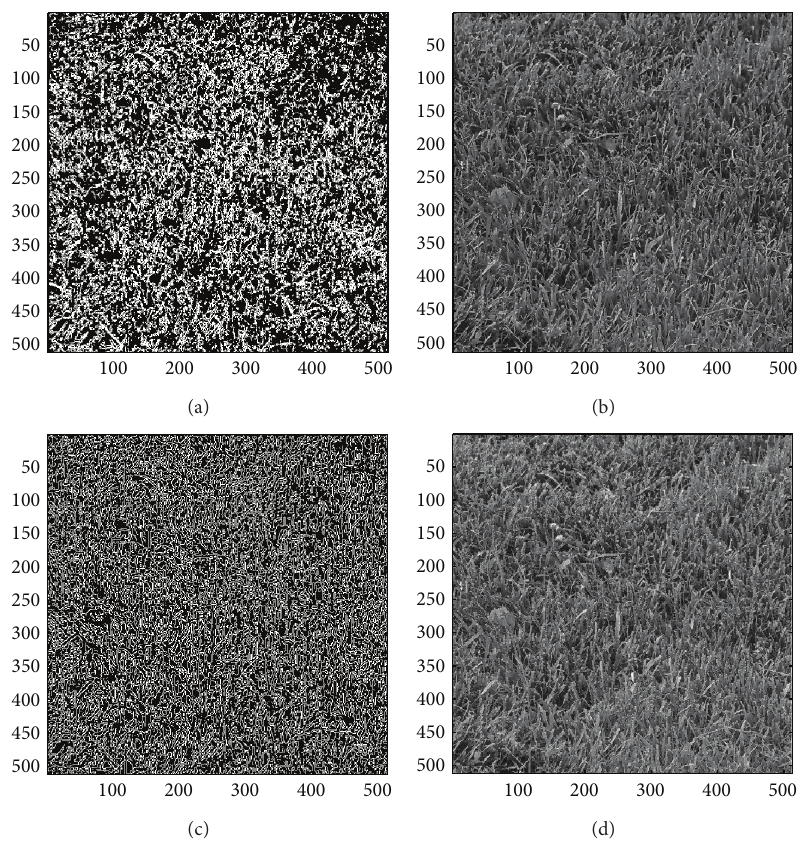
= 18 in the image “Grass.” (b) Result by HVD with scaling factor 𝑠 = 1.0 . (c) Edges detected Figure 10: (a) Edges detected by HVD with 𝜃 eth by Canny operator in the image “Grass.” (d) Result by Canny operator with scaling factor 𝑠 = 1.0